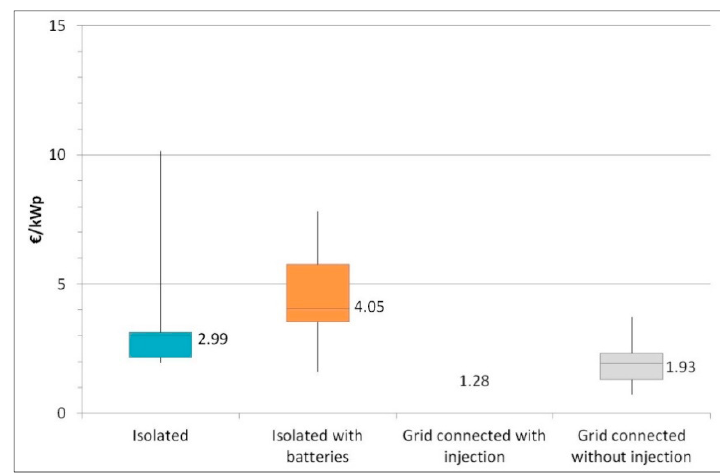
Figure 6. Unit cost of the installation (€/kWp) according to its connection to the network.